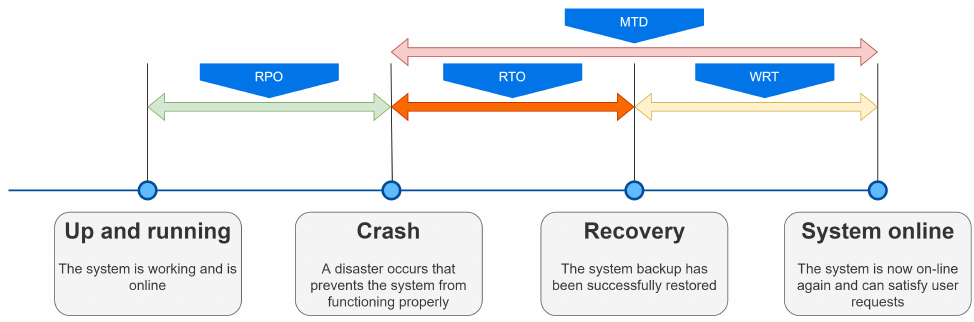
Figure 1. Disaster recovery